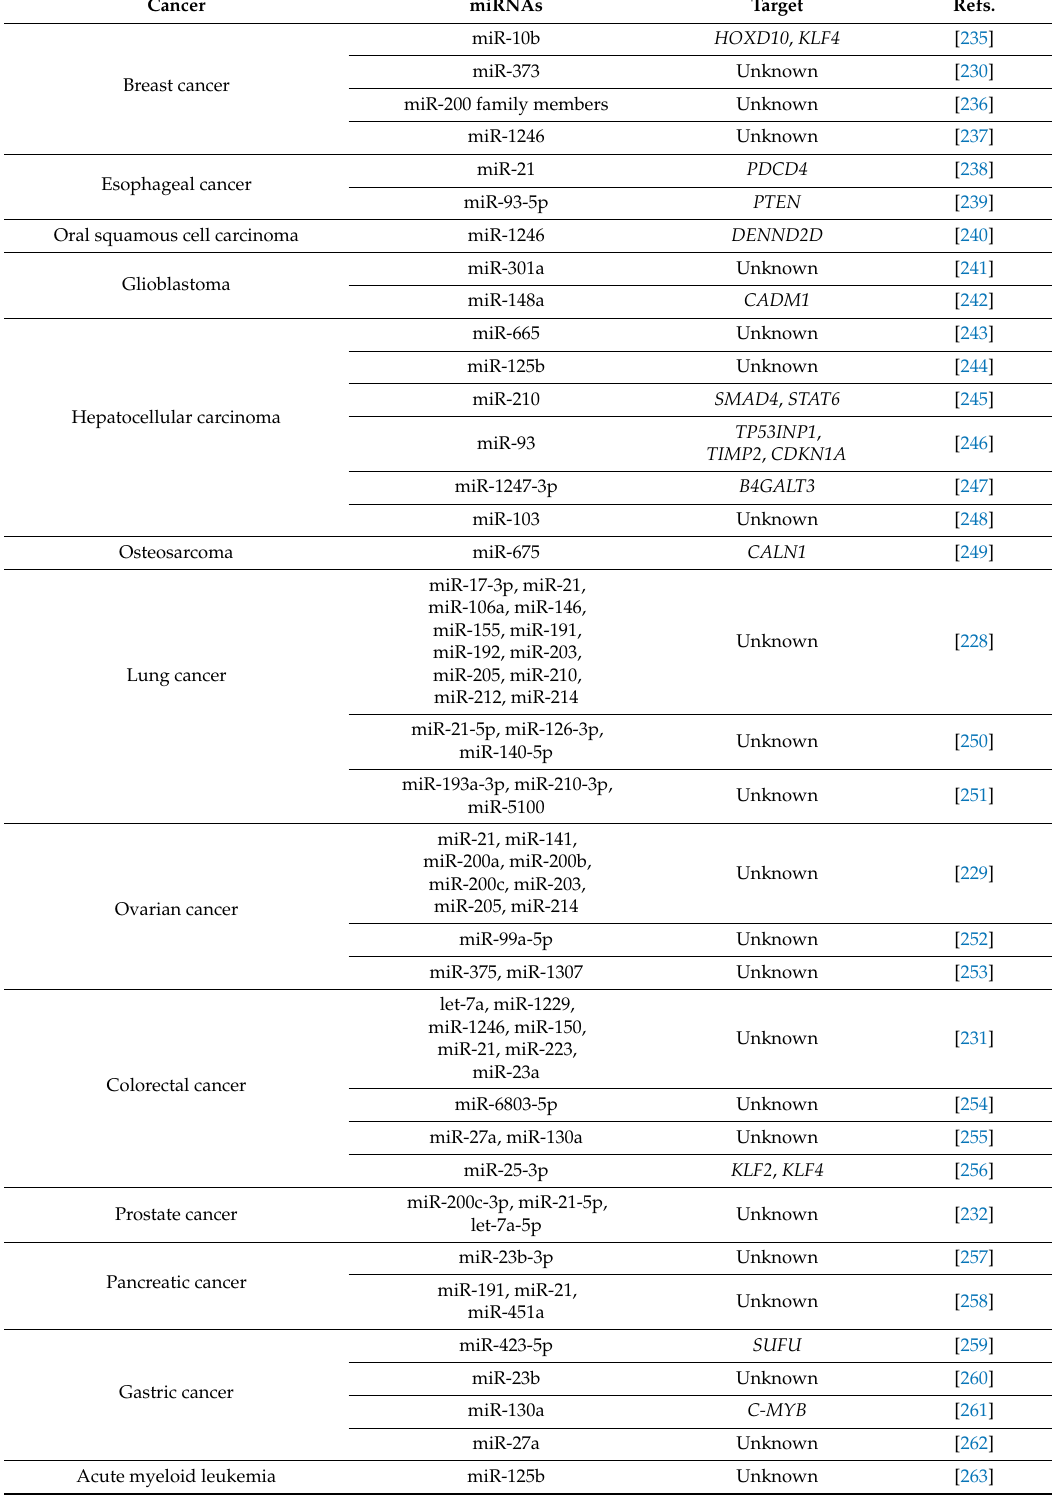
Table 2. Exosomal microRNAs (miRNAs) and their targets that are involved in cancer